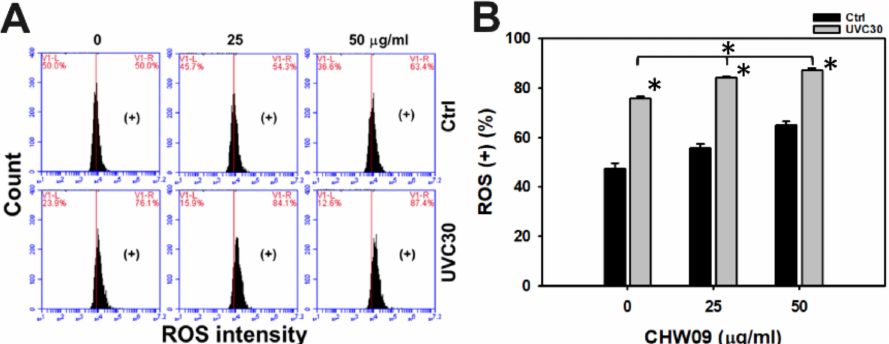
Figure 5. Changes of Reactive Oxygen Species (ROS) generation of UVC and / or CHW09 treatments in oral cancer Ca9-22 cells. Cells were pretreated with UVC irradiation (0 and 30 J / m 2 ) and / or